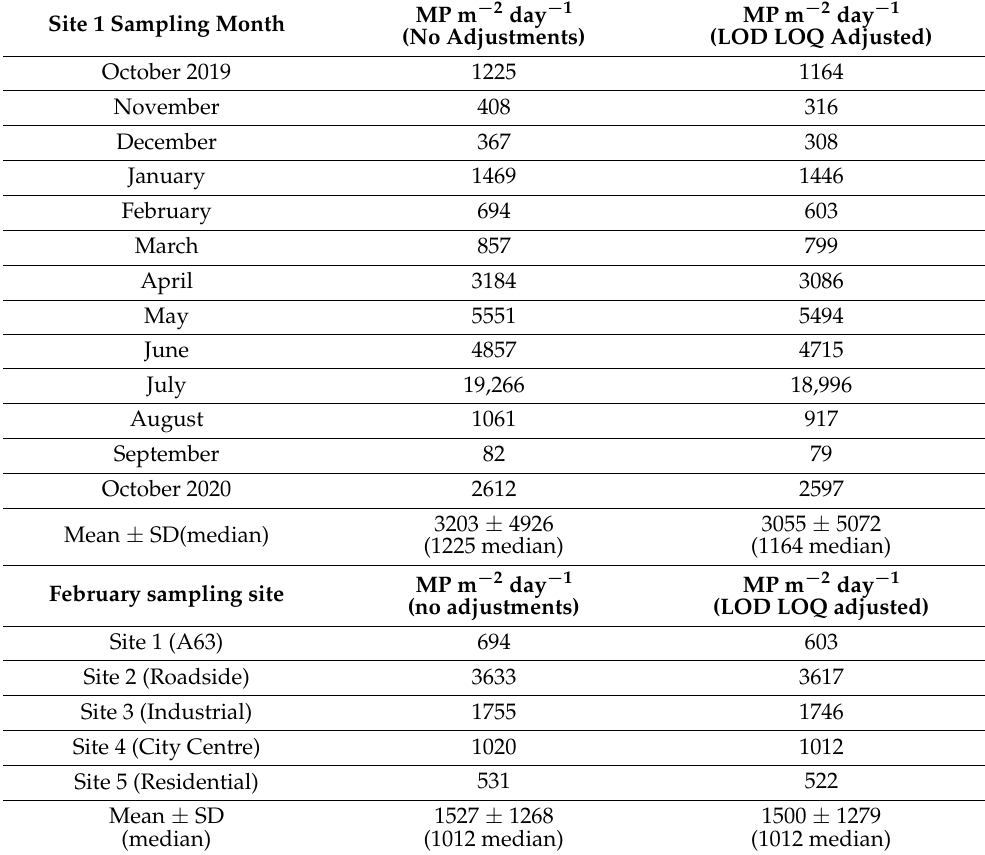
Figure 2. Total number of particles and MPs identified, within the 2-week sampling period, for sampling Site 1 (A63). The total rainfall during each 2-week sampling period is presented alongside. April and May coincided with an official SARS-CoV lockdown. Table 2. MP levels detected at Site 1, and from all five sampling sites, before and after LOD and LOQ